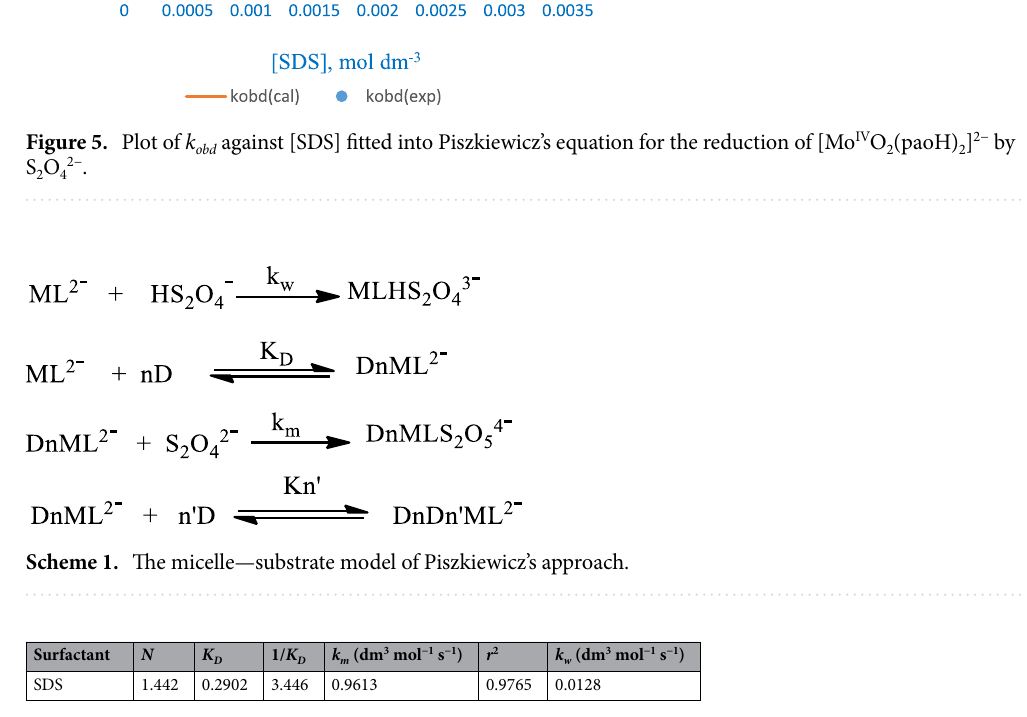
Table 4. Parameters of Piszkiewicz